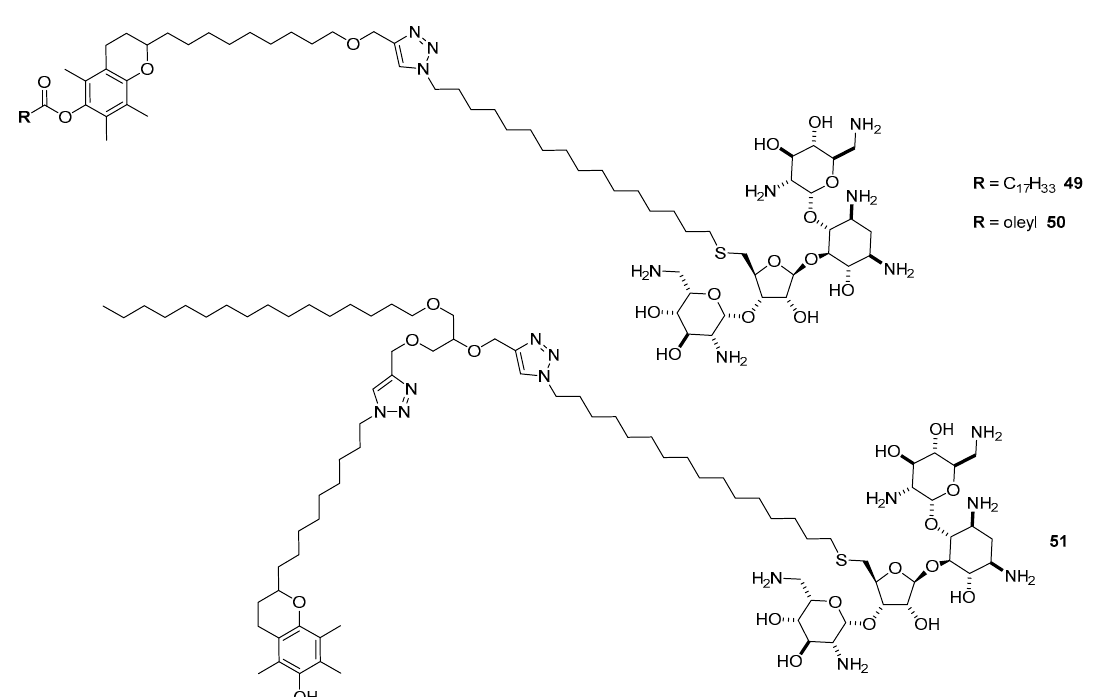
Figure 14. Structures of neomycin-vitamin E lipids 49 – 51 .